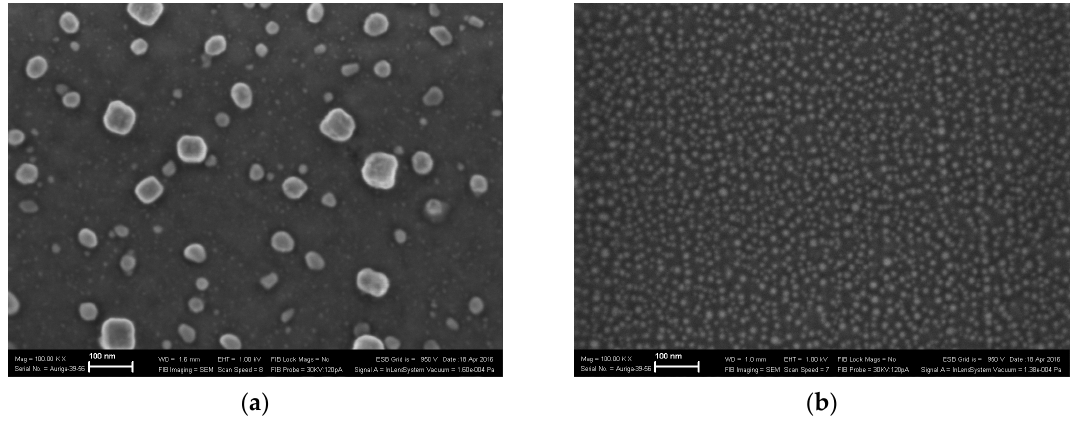
Figure 74. SEM images of FINEMET ribbons with different permeability: F1, μ r = 34,500 ( a ) and F2, μ r = 190,000 ( b ). Adapted from Ref. [102] with permission from Elsevier: Materials Chemistry and Physics, Vol. 180, Oshtrakh M.I., Klencsar Z., Semionkin V.A., Kuzmann E., Homonnay Z., Varga